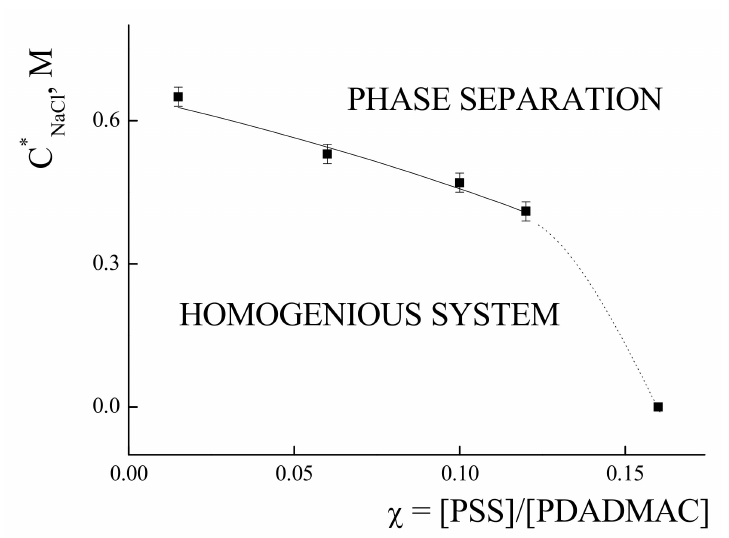
Figure 3. The decrease in the C* NaCl from 0.62 to 0.45 was observed with changing χ from 0.015 to 0.12, with a further sharp decrease to C* NaCl = 0.005 M for the IPEC with χ *.